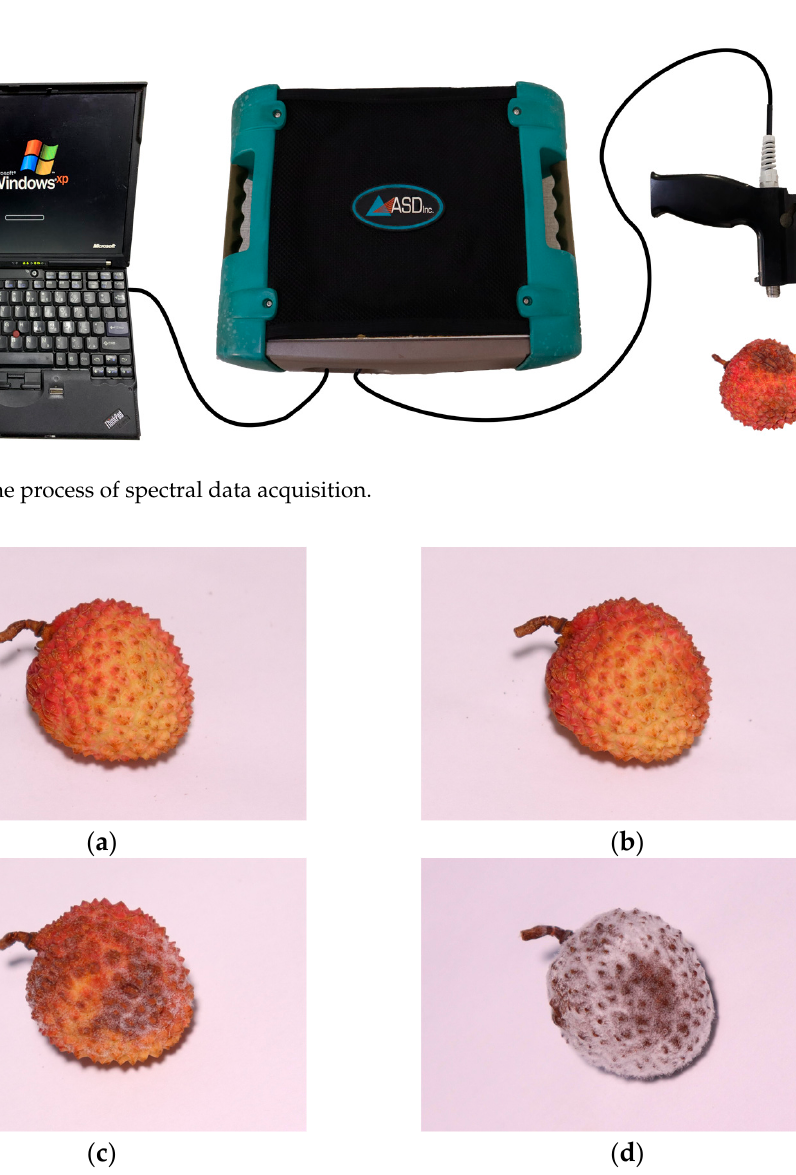
Figure 4. Images of litchi fruit at different disease stages: ( a ) healthy, ( b ) latent, ( c ) mild and ( d ) severe.